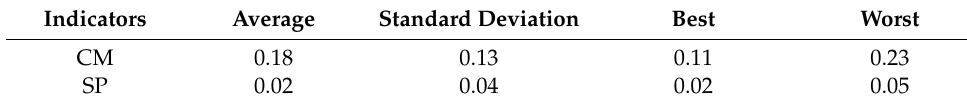
Table 3. Statistical performance information (50 independent runs).